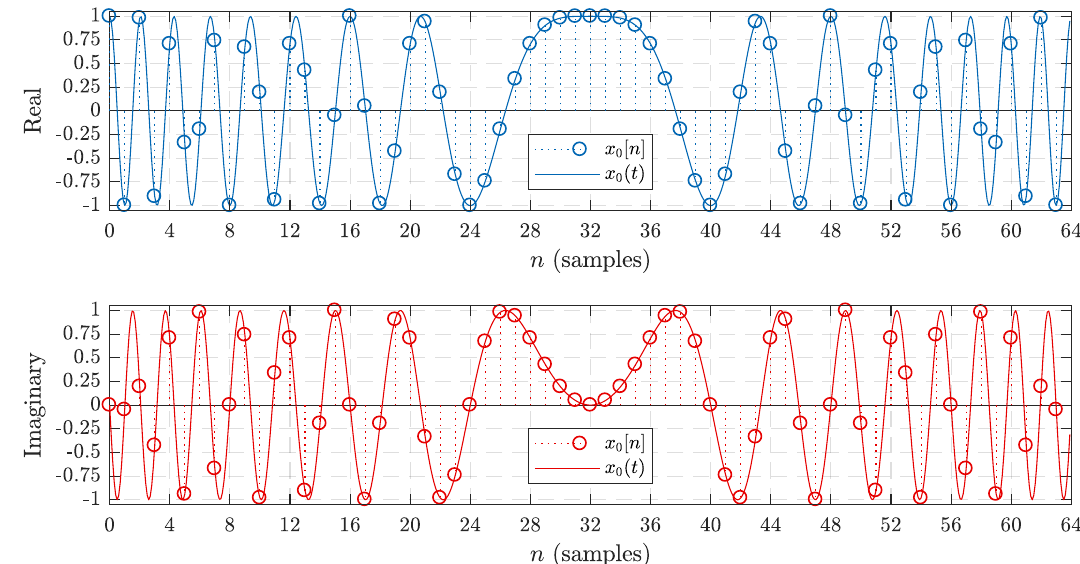
Figure 2. Example of discrete-time and continuous-time basic chirp waveforms with SF = 6 and BW = 125